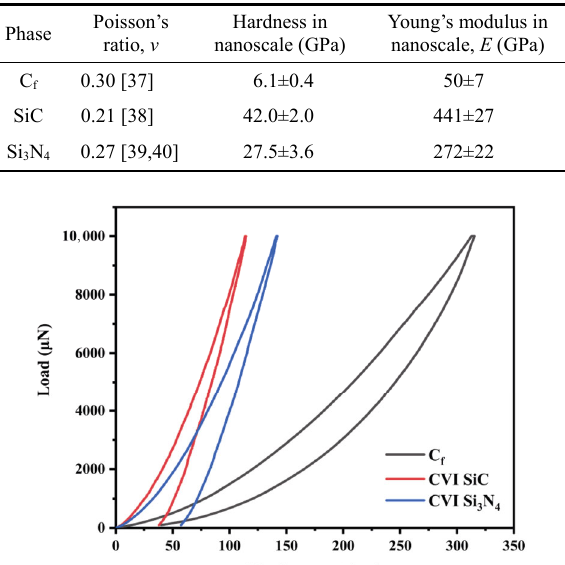
Table 2 Young’s modulus and hardness in nanoscale of C f , SiC, and Si 3 N 4